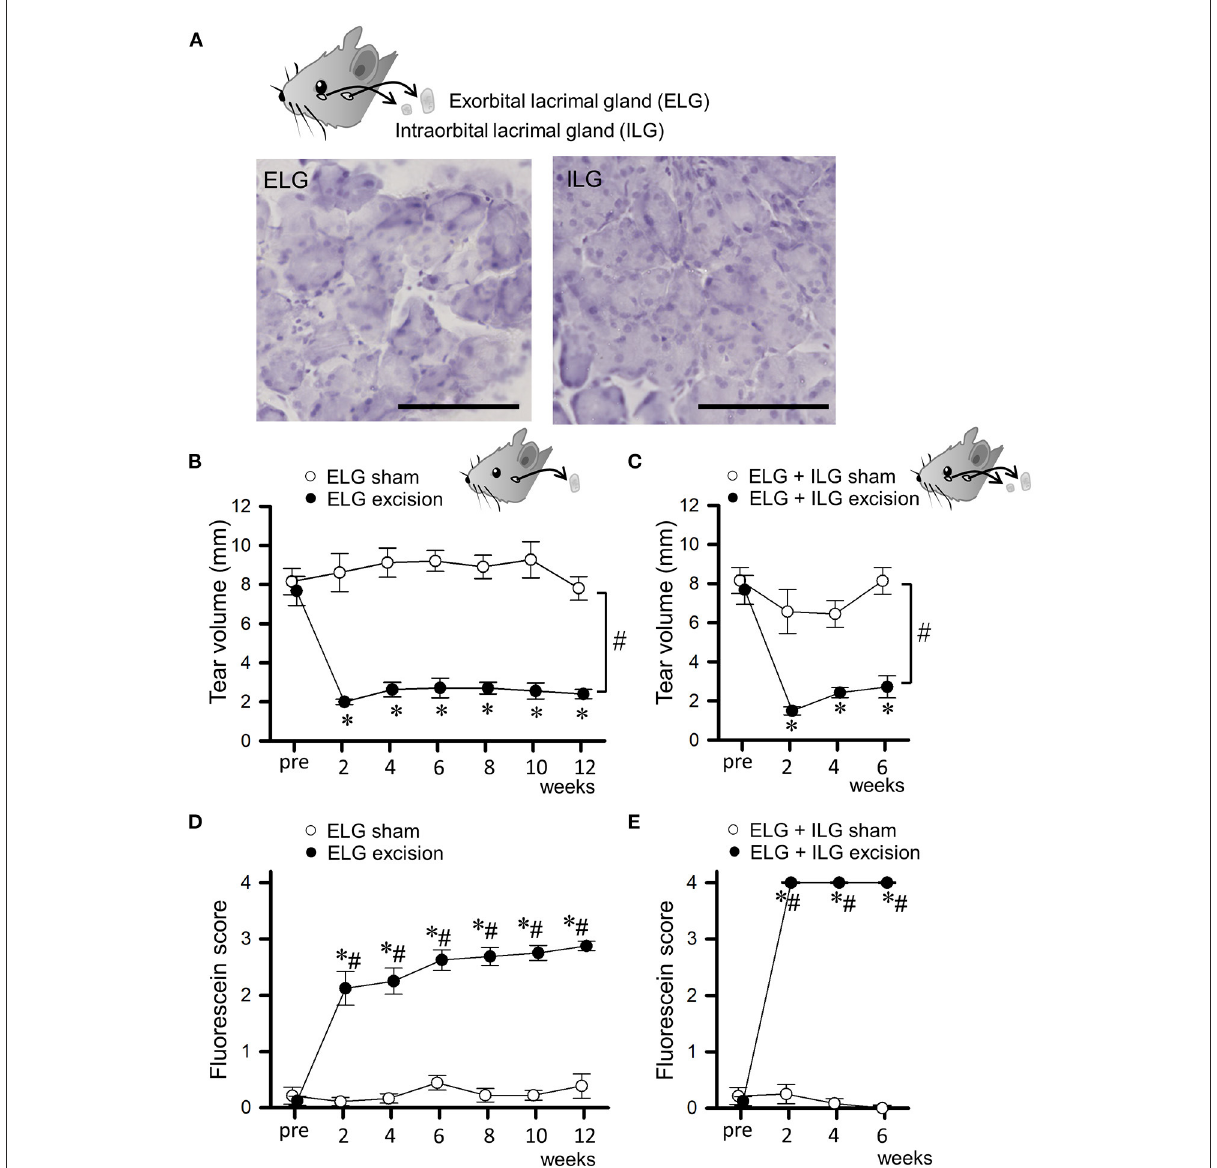
FIGURE1 Changes in tear volume and fluorescein score after excision of lacrimal glands. (A) Microscopic images of the excised exorbital lacrimal glands (ELGs) and intraorbital lacrimal glands (ILG). ELGs and ILGs were excised from an 8-week-old C57BL/6J mouse and stained with hematoxylin. The horizontal bars represent 100 µ m. (B,C) Tear volume measured with phenol red thread placed under the lower eye lid for 30s. The mean lengths of the red-stained portion in ELG or ELG + ILG sham-operated (open circles), ELG excision [ (B) , closed circles], and ELG + ILG excision mice [ (C) , closed circles] are shown at each time point. (D,E) The mean fluorescein scores in ELG or ELG + ILG sham-operated (open circles), ELG excision [ (D) , closed circles], and ELG + ILG excision mice [ (E) , closed circles] are shown at each time point. Each point and the corresponding vertical bar represent the mean ± SEM ( n = 8). * P < 0.05 vs . before the excision, # P < 0.05 vs . the sham-operated